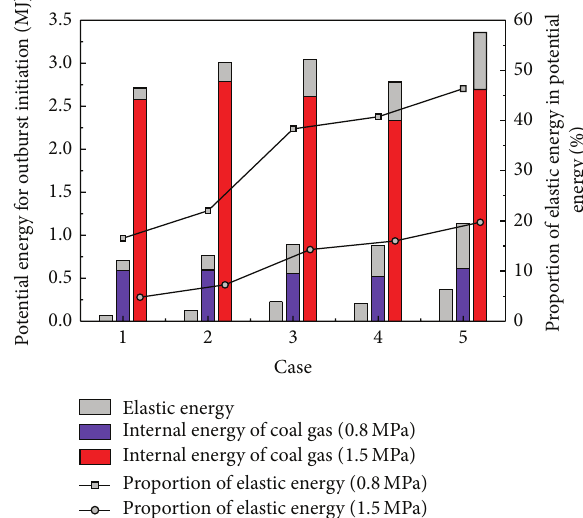
Figure 5: The effect of coal gas and tectonic stress on energy for outburst initiation in front of the roadway.